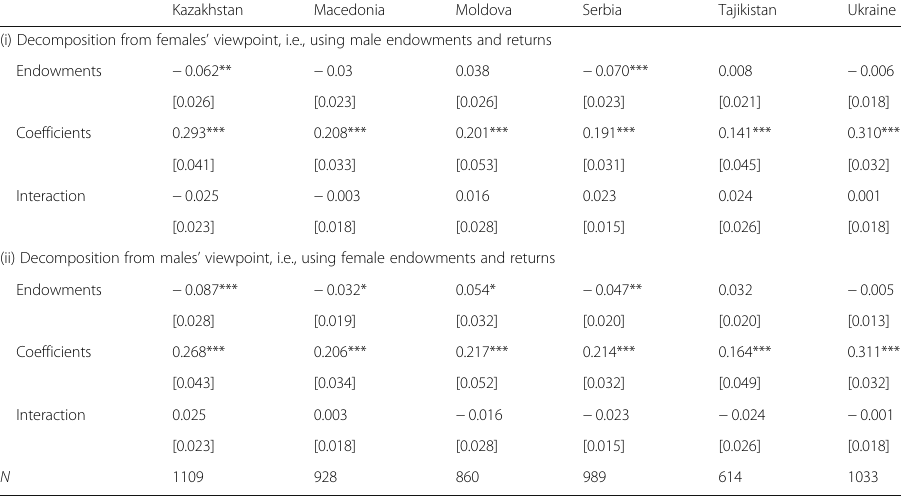
Table 12 Overall income decompositions, sensitivity analysis: